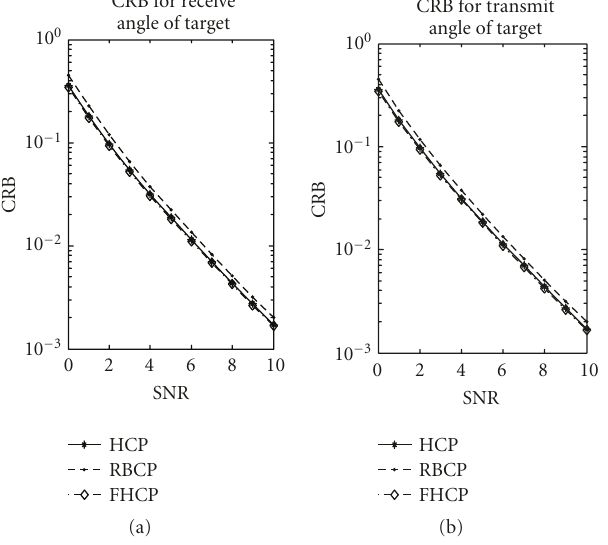
= 0 ◦ , θ = 0 ◦ versus r 1 t 1